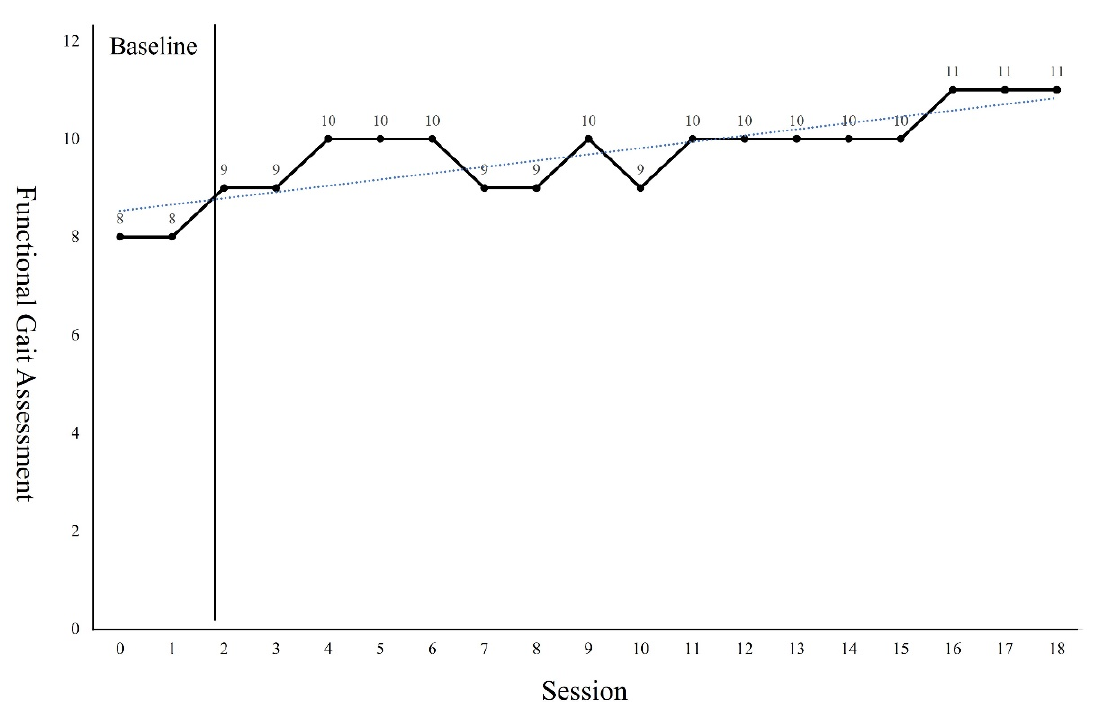
Figure 5. Changes of Functional Gait Assessment.